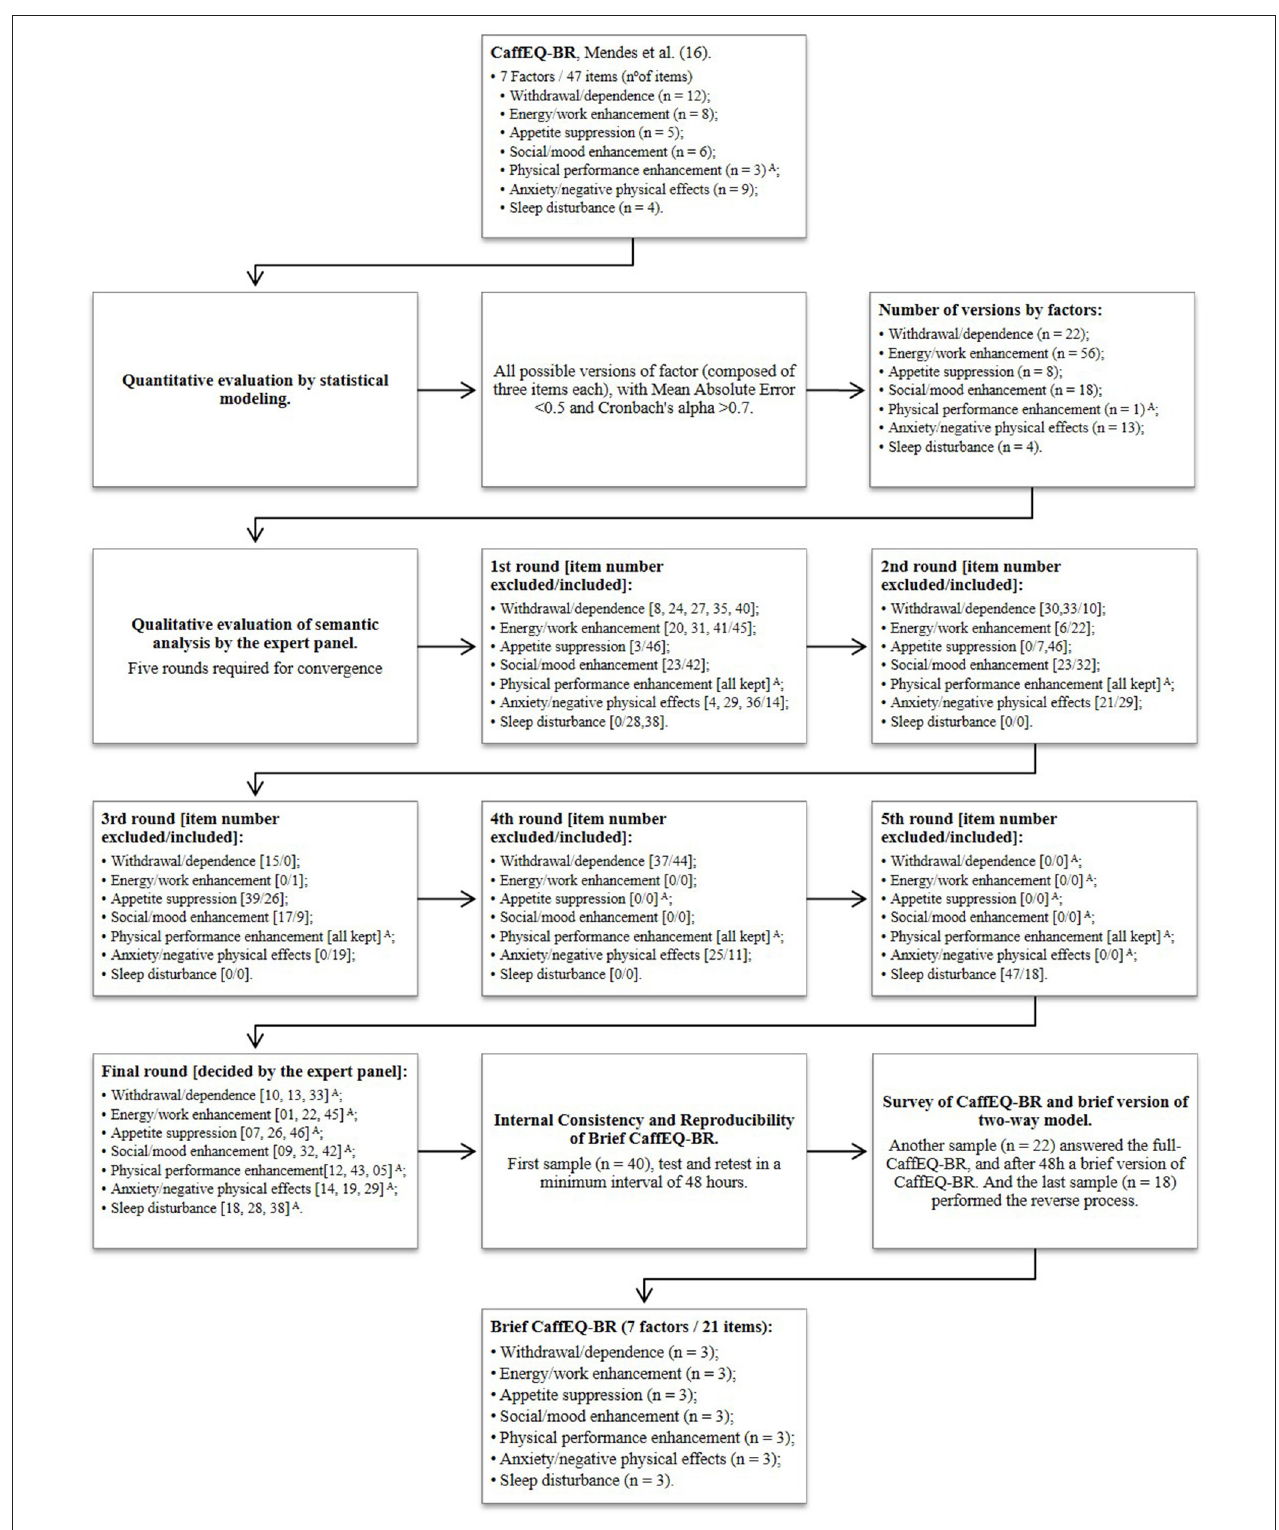
FIGURE 1 | Process stages of the brief version of Brazilian Caffeine Expectancy Questionnaire in Brazil (B-CaffEQ-BR). A Three items are defined per factor. In this case, the factor Physical performance enhancement has only three items, so it was not reduced; Note: Number zero [0] indicates no change.